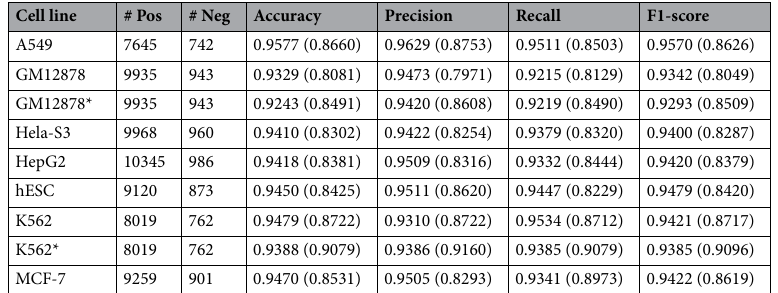
Table 1. The performance of the cell-specific D-miRT models on the 10% test data. The numbers in parenthesis are those without threshold values. The #Pos and #Neg are the number of positive samples and negative samples used to test the trained cell-specific models. The two rows with “*” next to cell line names are from the two-layer